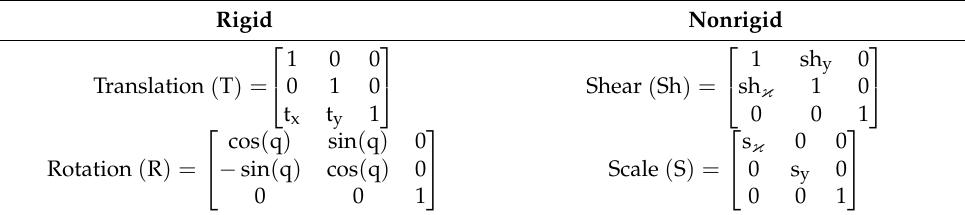
Table 1. Rigid and nonrigid transformation